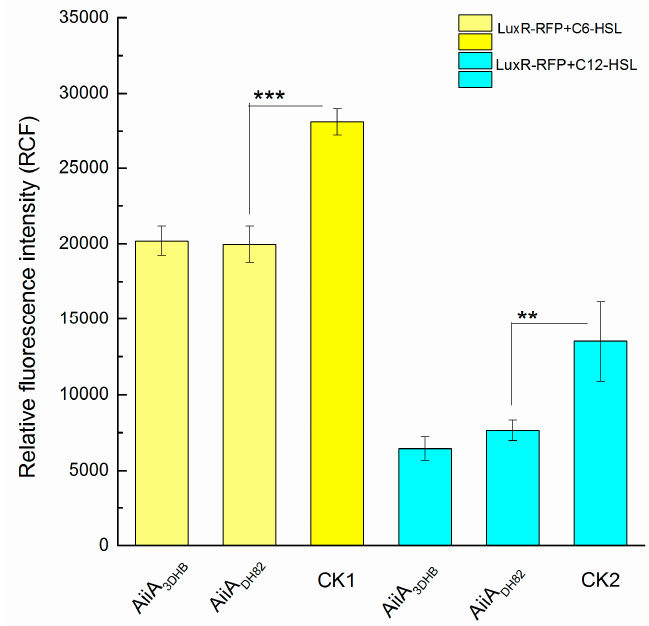
Figure 4. Activities of probable quorum quenching enzymes on AHL degradation. The degradation activities of AiiA DH82 aredetermined by the relative fluorescence intensity generated bythe reporter operon (LuxR-P luxI-lacO -RFP). The experimental groups with added AHL are separately treated with AiiA DH82 (C6-HSL in yellow and C12-HSL in cyan), comparedwith the grouptreated with AiiA 3DHB (used as the positive control) and the control checks (CKs) of untreated AHL. Error bars are used to determine the standard deviation. Statistical analysis results with a significant difference aremarked using * (significant differences at p < 0.01 marked as *** and 0.01 < p < 0.05 marked as **).